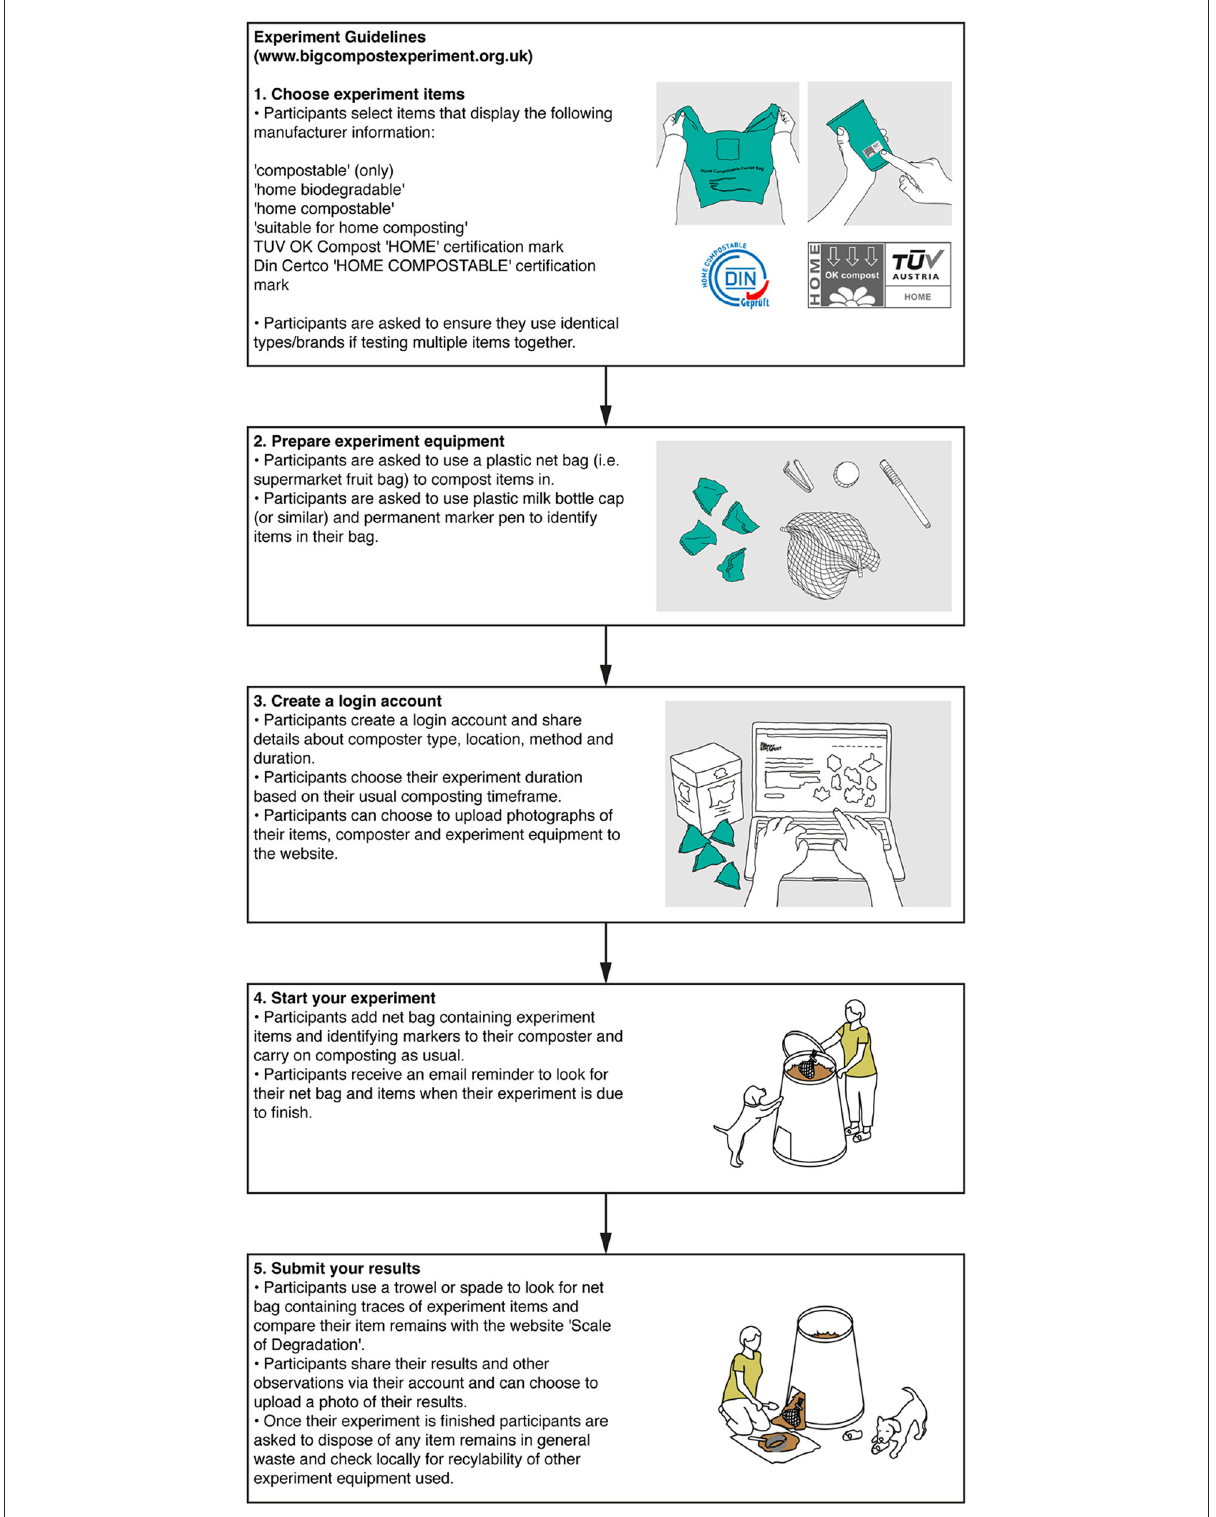
FIGURE2 Illustration of the Big Compost Experiment home compost experiment